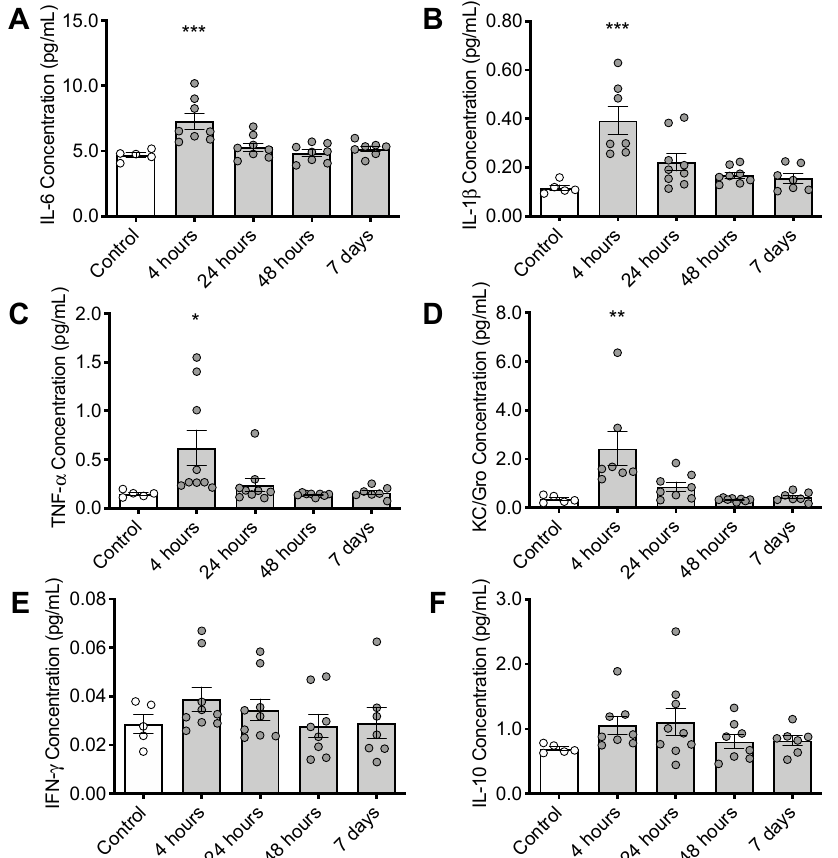
Figure 4. Timeline of inflammatory changes in the brain following CS treatment. Cortical cytokine levels of ( A ) interleukin 6 (IL-6), ( B ) interleukin 1 β (IL-1 β ), ( C ) tumor necrosis factor alpha (TNF α ), and ( D ) chemokine (C-X-C motif) ligand 1 (CXCL1, KC / Gro), ( E ) Interferon gamma (INF γ ) and ( F ) interleukin 10 (IL-10) * p < 0.05, ** p < 0.01, *** p < 0.001. Error bars plotted as mean ± SEM.